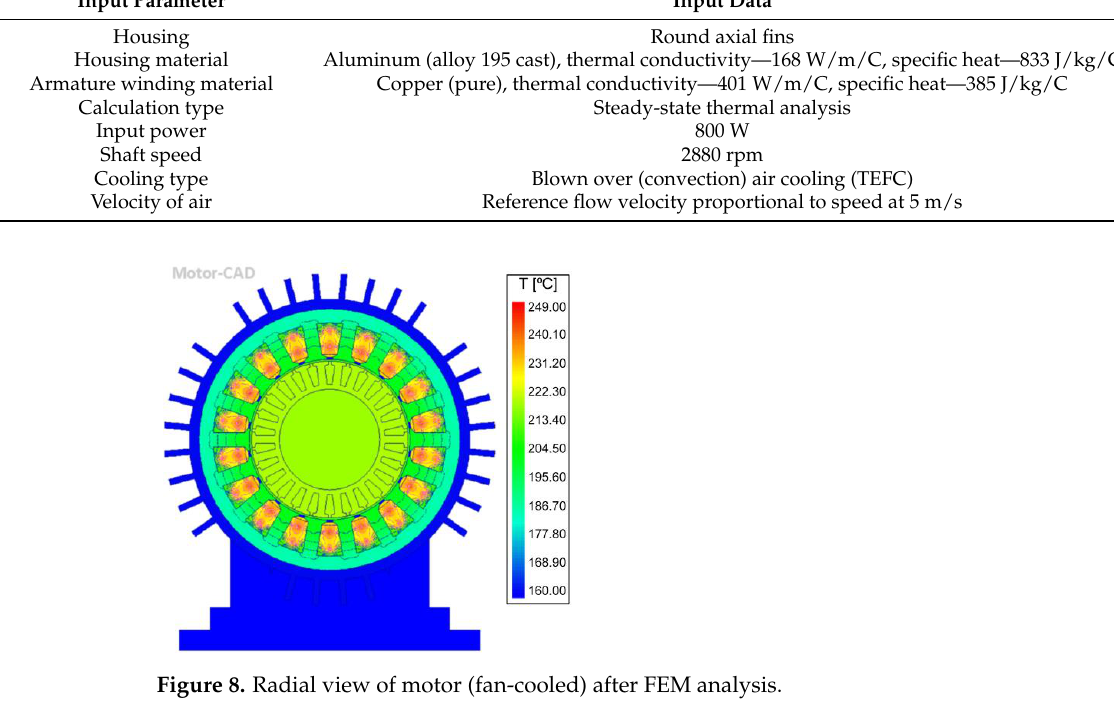
Figure 7. Radial view of fan-cooled motor mainly showcasing the housing type-axial fins (the windings, stator, and rotor) ( a ); axial view of fan-cooled motor depicting air flow coming from fan cooling system through the arrows ( b ). Table 5. Input parameters for thermal analysis on fan-cooled motor (ANSYS Motor-CAD).